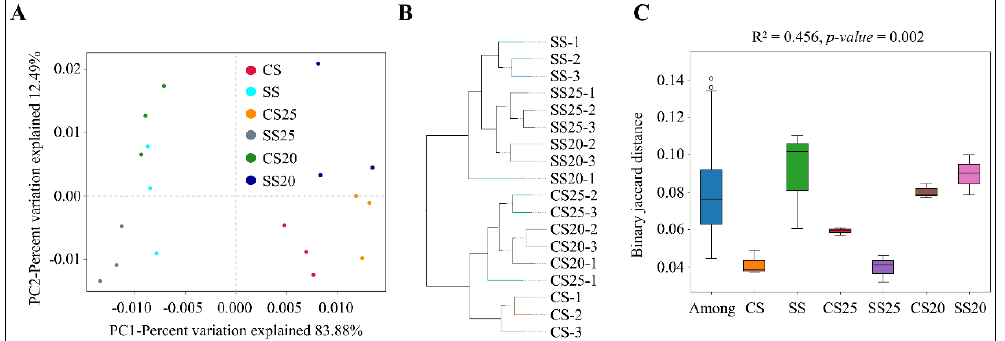
Figure 4. Beta diversity analysis. ( A ) Principal component analysis (PCA). Two principal components (PC1 and PC2) of PCA are shown in the coordinates. The same color points belonged to the same soil group are closer to each other and the samples from di ff erent soil groups are farther apart. ( B ) Unweighted pair-group method with arithmetic mean (UPGMA) analysis is clustered according to are. ( C ) Analysis of similarities (ANOSIM) revealed the variation in the composition